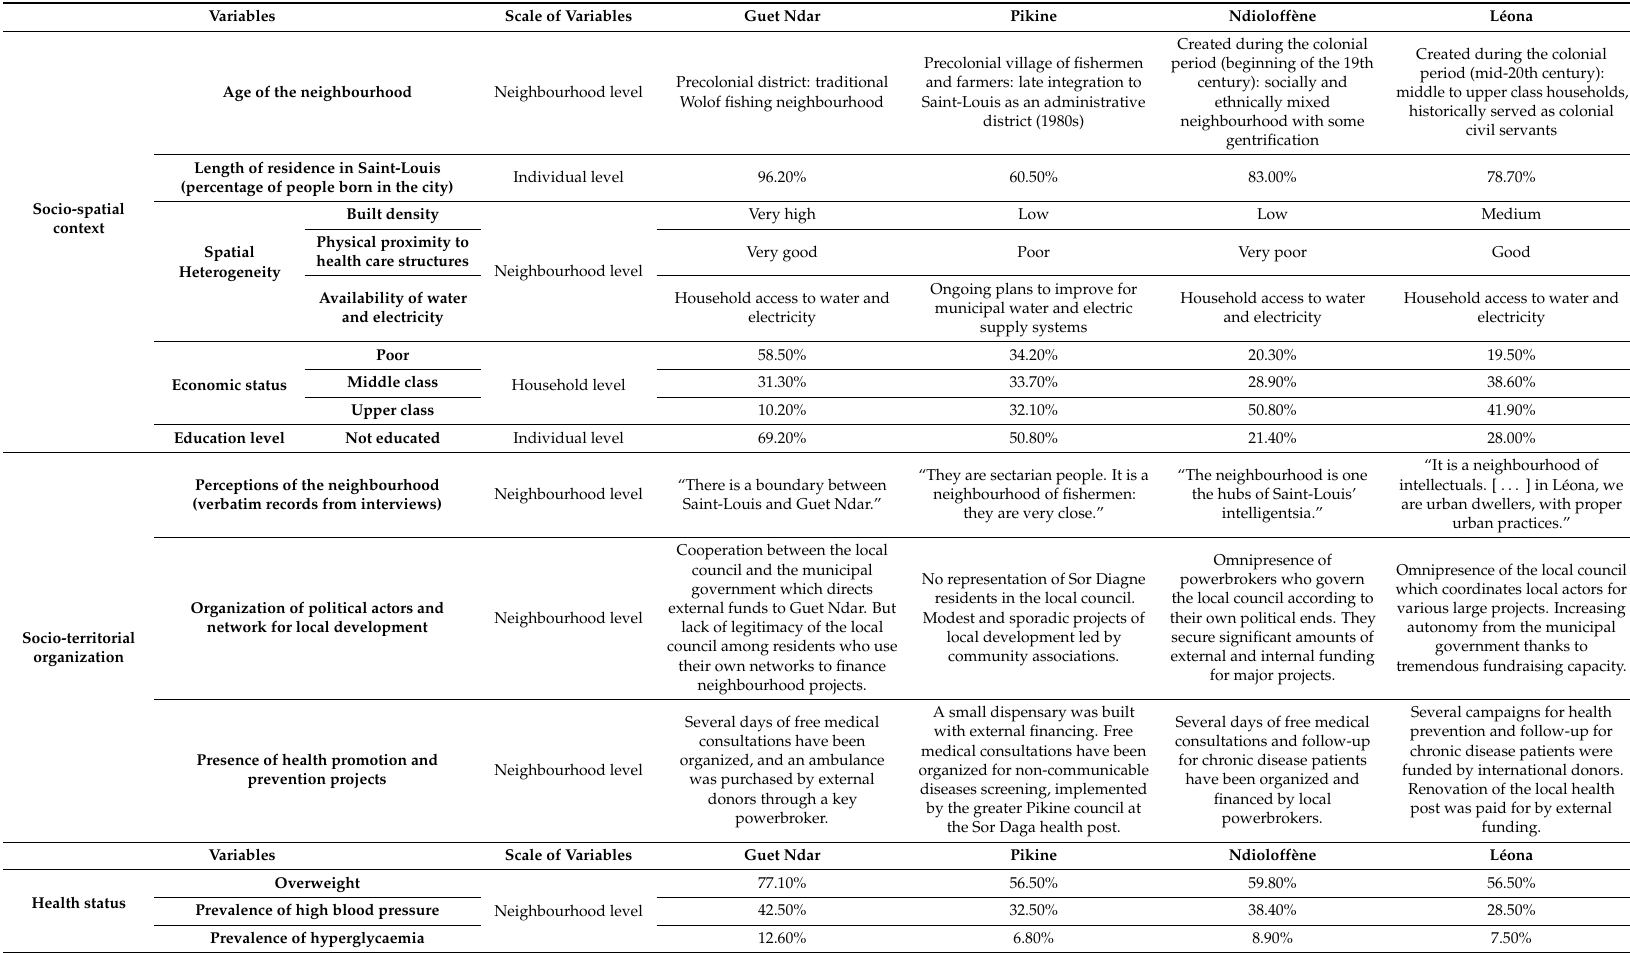
Table 2. Categorization of the four studied neighbourhoods by socio-territorial organization and health